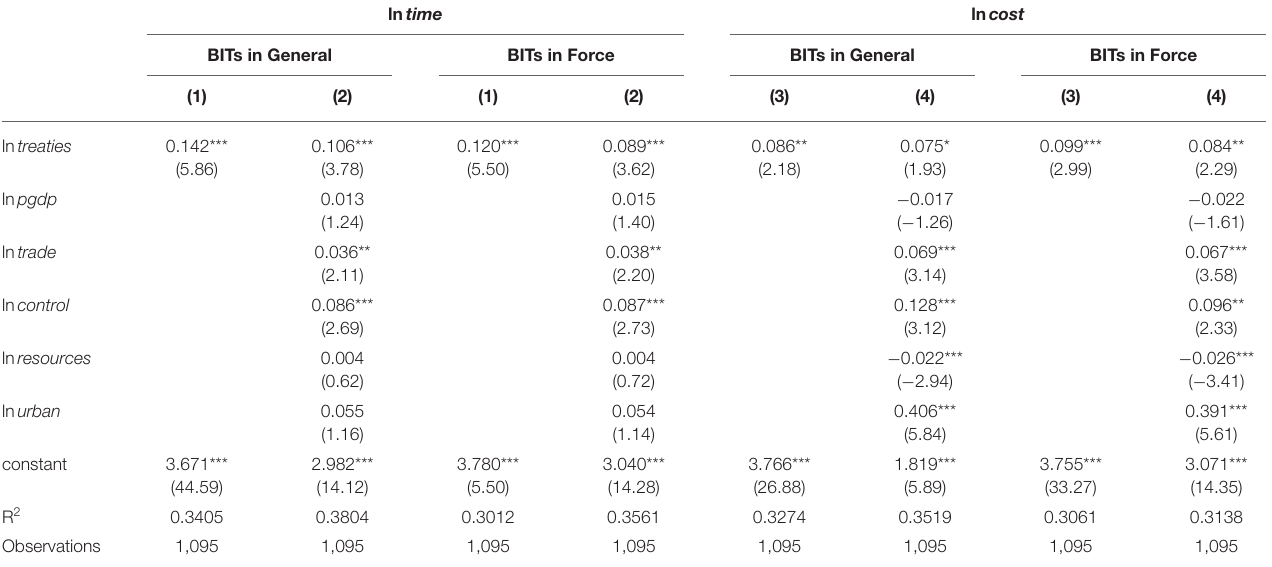
TABLE 6 | Results of time and